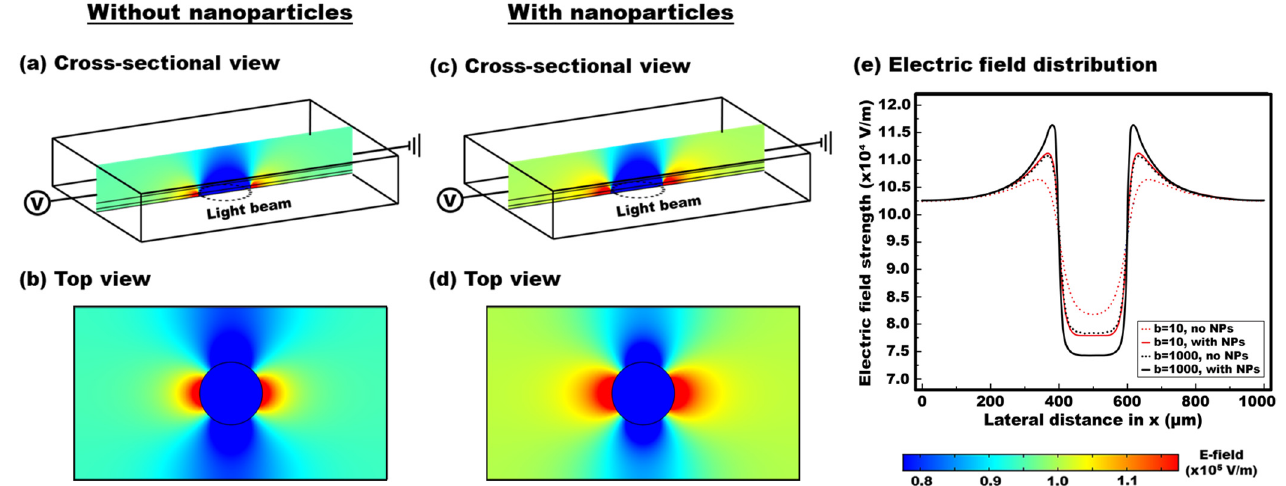
Figure 4. Simulation results of electric field distribution to demonstrate plasmonic-enhanced DEP performance of FEOET devices . ( a – d ) Cross-sectional and top views of the electric field strengths are shown under the illumination of a circular light beam for the device without and with plasmonic nanoparticles. The photoconductivity ratio is assumed at b = 10. By using the arrayed nanoparticle layers above the TiOPc layer, electric field strengths can be significantly enhanced at both sides of the light beam in the lateral direction, even at the same light illumination. ( e ) The field strength data are extracted on the surface of the dielectric layer. A stronger field gradient can be created with the presence of plasmonic nanoparticles. This simulation study was repeated for another conductivity ratio at b = 1000 to represent the use of high-quality photoconductive material (see black solid and dotted curves). By using plasmonic nanoparticles as light scattering elements, even low-quality photoconductive materials at b = 10 can induce the strong field gradient as comparable as high-quality photoconductive ones at b = 1000.